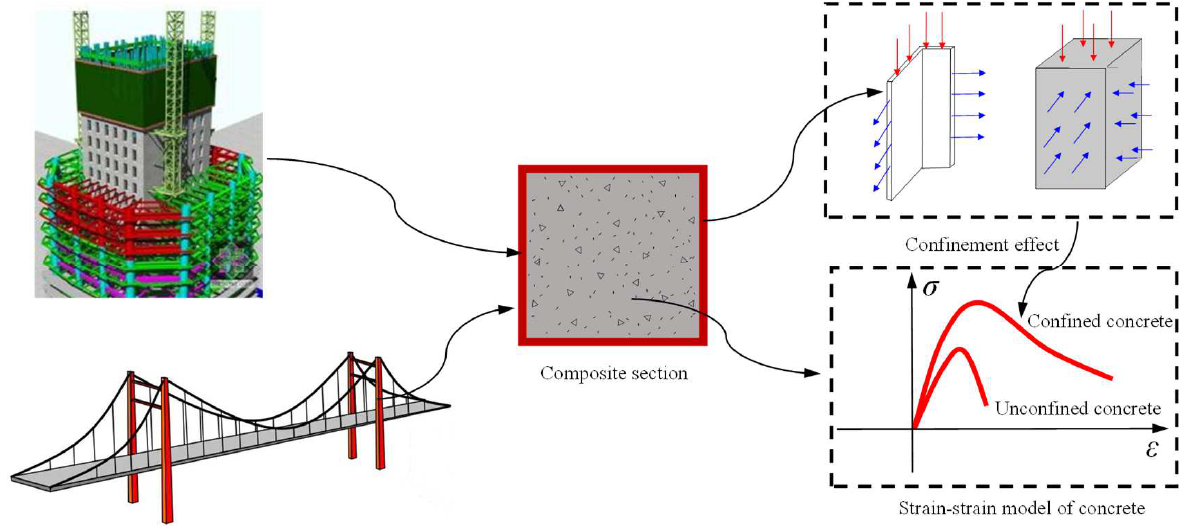
Figure 1. Applications of CFSTs in structural engineering.